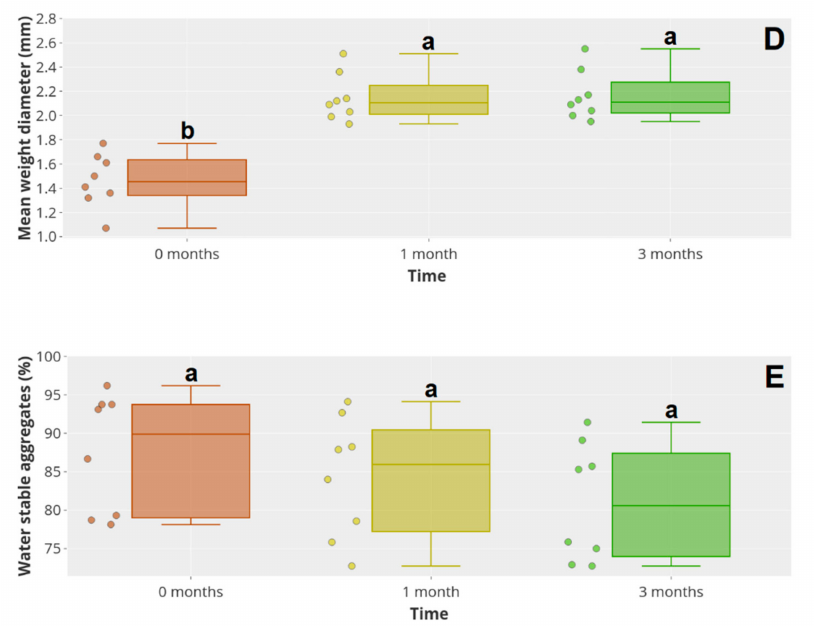
Figure 3. Di ff erences in soil physical properties within the fig orchard study site over the study period: ( A ) soil water content, ( B ) water holding capacity, ( C ) bulk density, ( D ) mean weight diameter, and ( E ) water-stable aggregate distribution. Upper hanging bar (maximum), lower hanging bar (minimum), upper box line (quartile 3), line (median) and lower box line (quartile 1). Di ff erent lower-case letters represent significant di ff erences between monitoring periods ( p < 0.05). Dots next to a boxplot represent measured values.